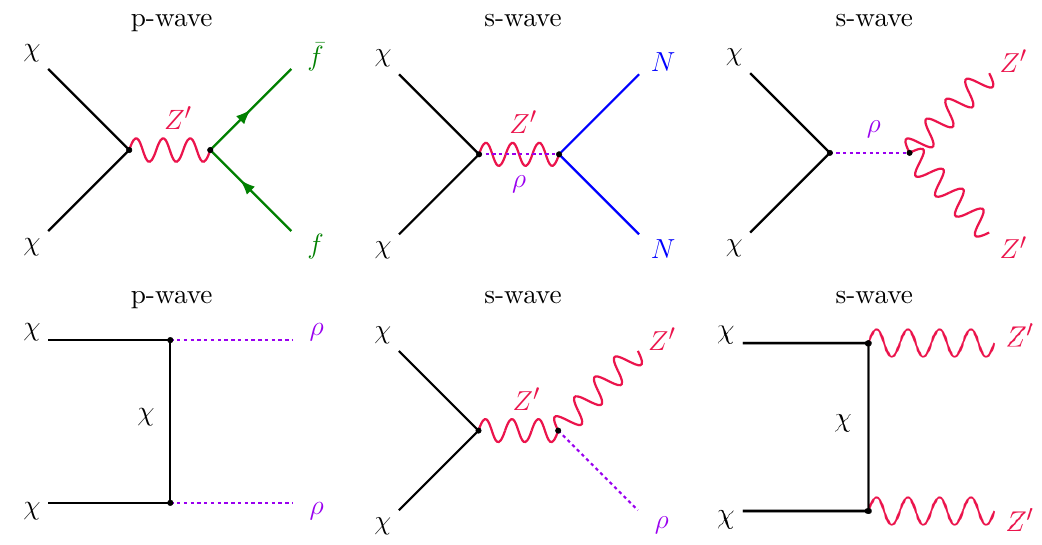
Figure 4 . Representative sample of relevant dark matter annihilation